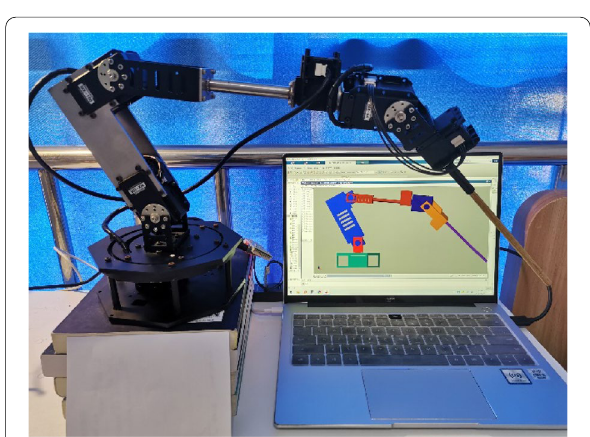
Figure 6 Synchronous control system between the virtual manipulator and the real